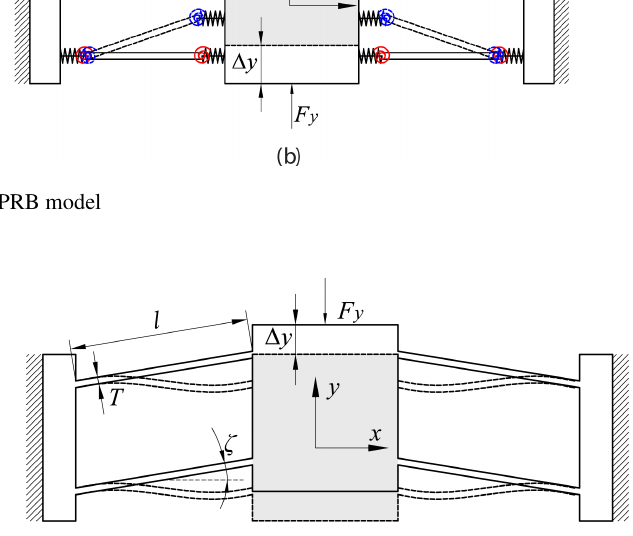
Figure 10. Fixed-guided bistable compliant